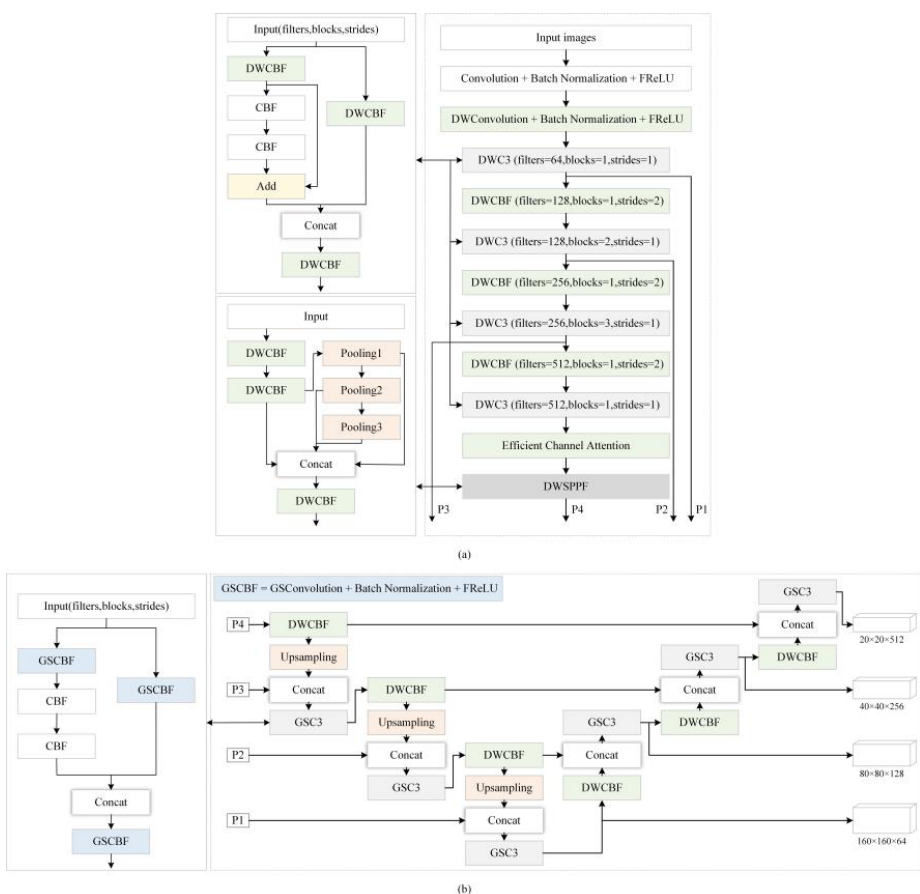
Figure 5. Coal and gangue detection model based on improved Yolov5s. ( a ) Structure of lightweight backbone network; ( b ) Structure of lightweight neck